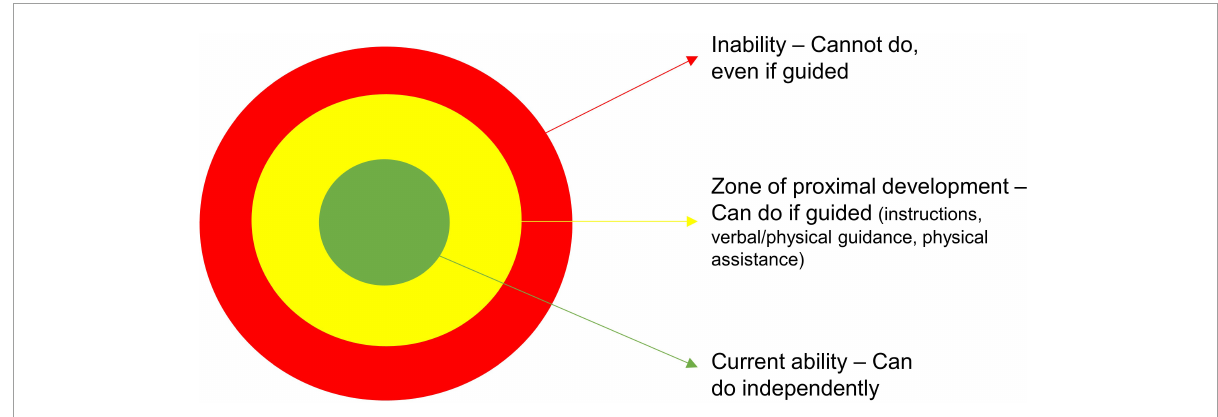
FIGURE1 Zone of proximal development. This figure, including the colors, is based on already existing interpretations of the theory “Zone of proximal development” (31, 43, 44). In the zone of proximal development, there is a spectrum of level of guidance needed for the child to be able to do the activity (i.e., instructions, verbal/physical guidance, and physical